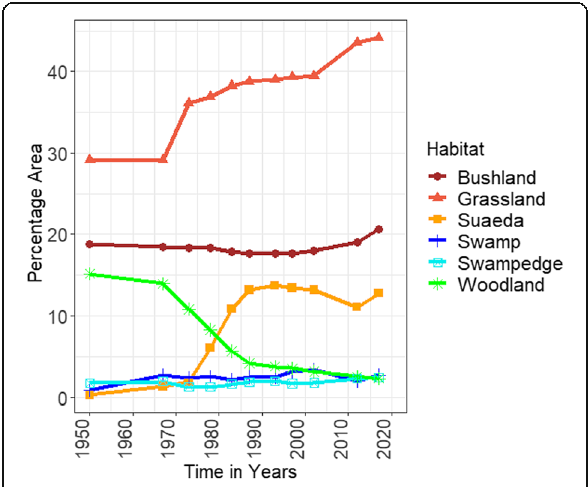
Fig. 2 Changes in the proportion area of six major habitats